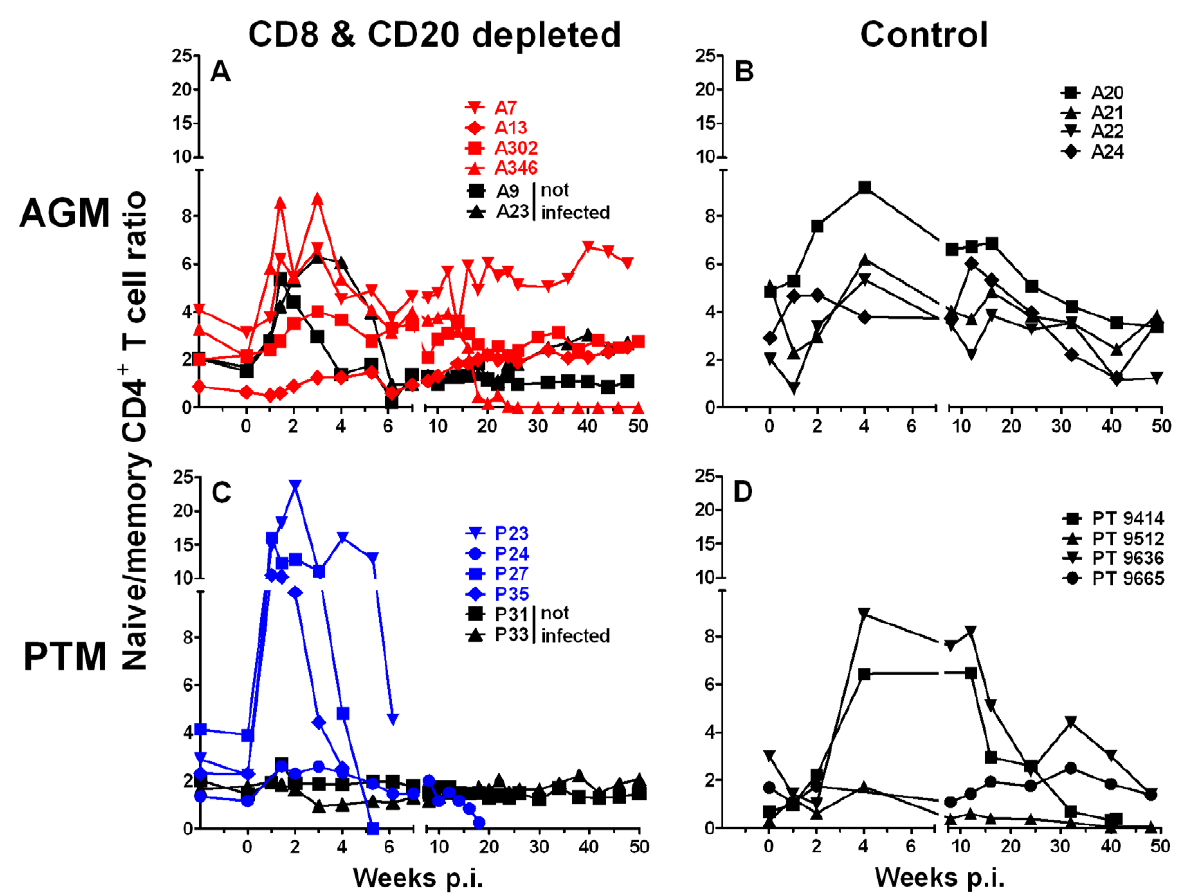
Figure 8. Increase in naive/memory CD4 + T cell ratio in SIV agmVer90 -infected, efficiently CD8 + and CD20 + lymphocyte-depleted PTM. Ratio of naive to memory CD4 + T cells in peripheral blood of vervet AGM ( A ) and PTM ( C ). SIV agmVer90 -challenged vervet AGM and PTM are shown with red and blue symbols, respectively. Animals that received the anti-CD8 and anti-CD20 depleting antibodies but were not inoculated with SIV are shown in black symbols. The ratio of naive to memory CD4 + T cells is shown for four control SIV-infected vervet AGM ( B ) and PTM ( D ) in black symbols and lines.